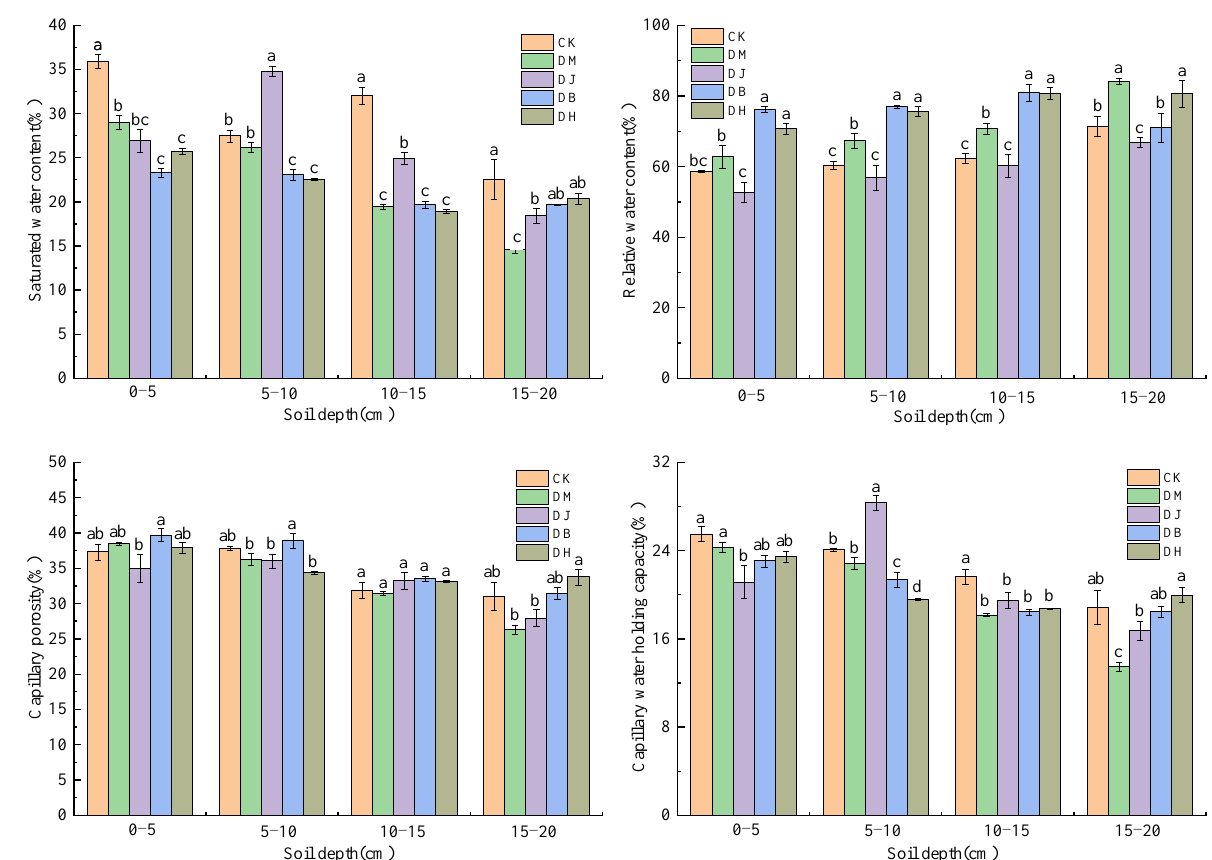
Figure 3. Comparison of soil physical properties with different treatments. CK: Salvia miltiorrhiza monoculture, DM: Salvia miltiorrhiza – Lolium perenne intercropping, DJ: Salvia miltiorrhiza – Cichorium intybus intercropping, DB: Salvia miltiorrhiza – Trifolium repens intercropping, DH: Salvia miltiorrhiza – Lolium perenne intercropping mode. Different lowercase letters indicate significant differences ( p < 0.05). Same below.